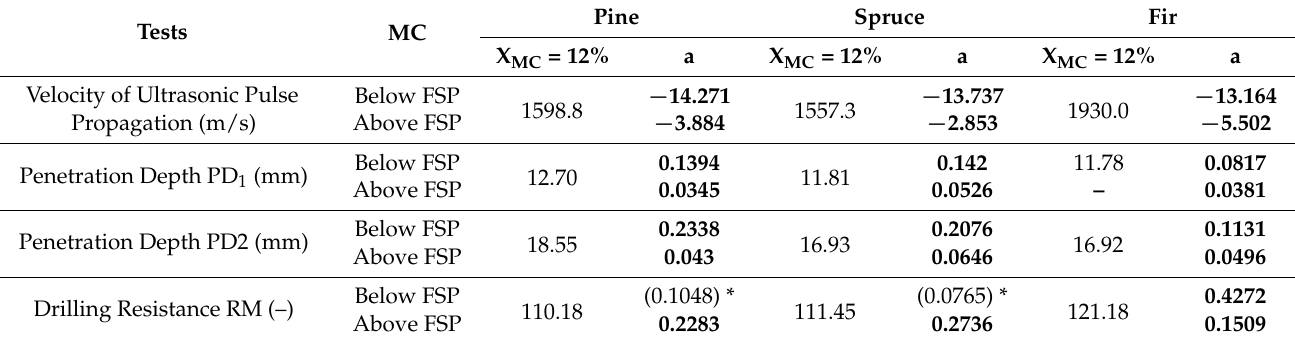
Table 5. Average values for reference level of MC = 12% and slope coefficient